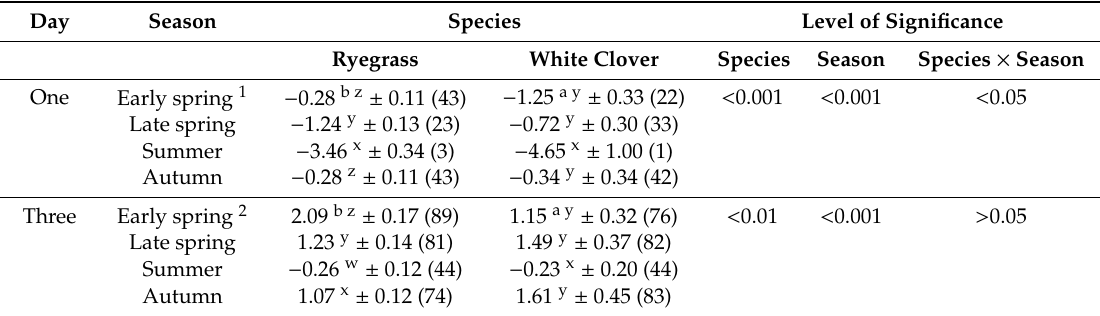
Table 3. Proportional selection by the pasture mix lambs of tagged ryegrass and tagged white clover on day one and three of grazing a plot during di ff erent seasons (logit lsmeans ± SEM, back transformed percentages (%) are given in